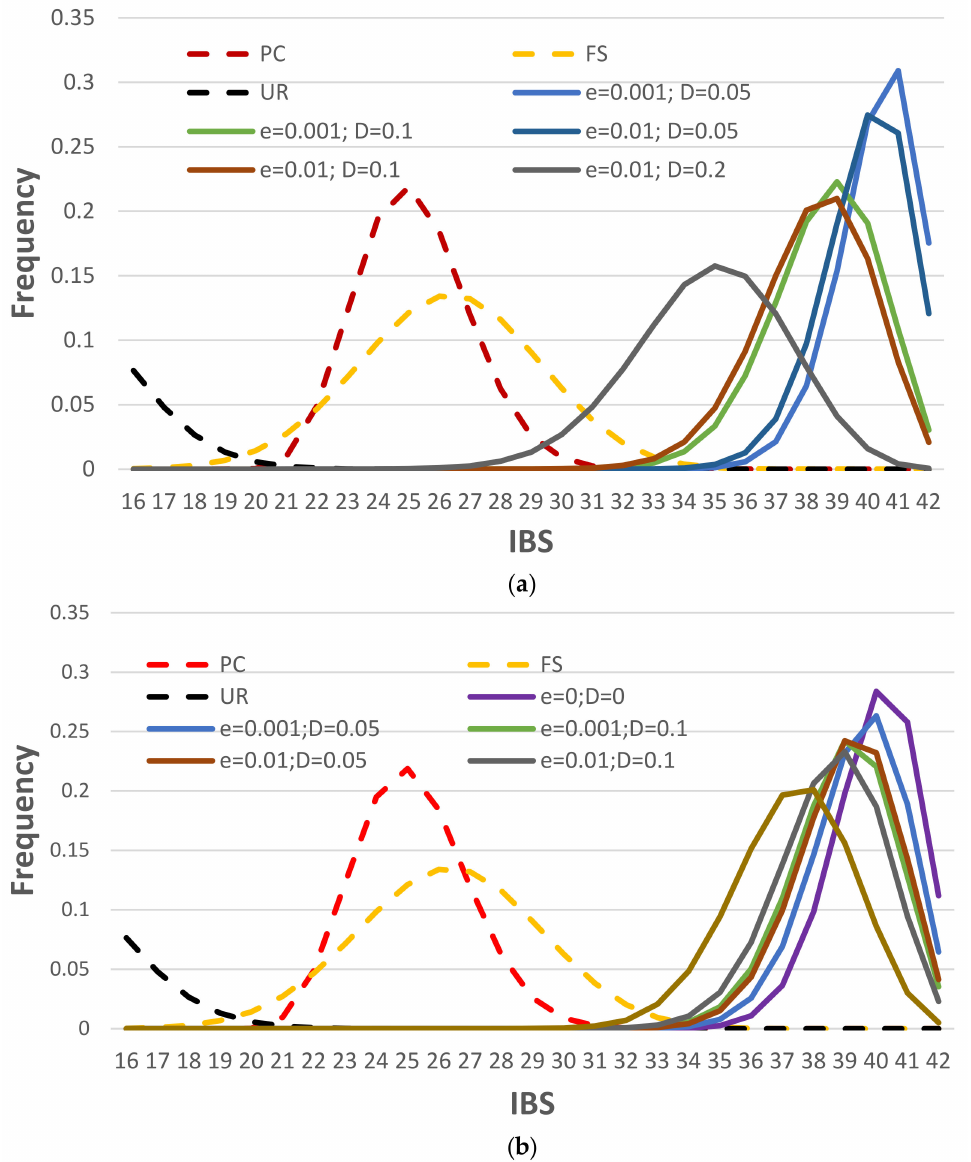
Figure 5. IBS distributions of unrelated and related pairs (UR, PC, and FS, in dotted lines) and pairs of the true profile versus the consensus profile with a given number of cells (in solid lines) for ( a ) 1 diploid cell and ( b ) 4 haploid cells. 1,000,000 simulations for each distribution. Missing alleles are excluded in counting